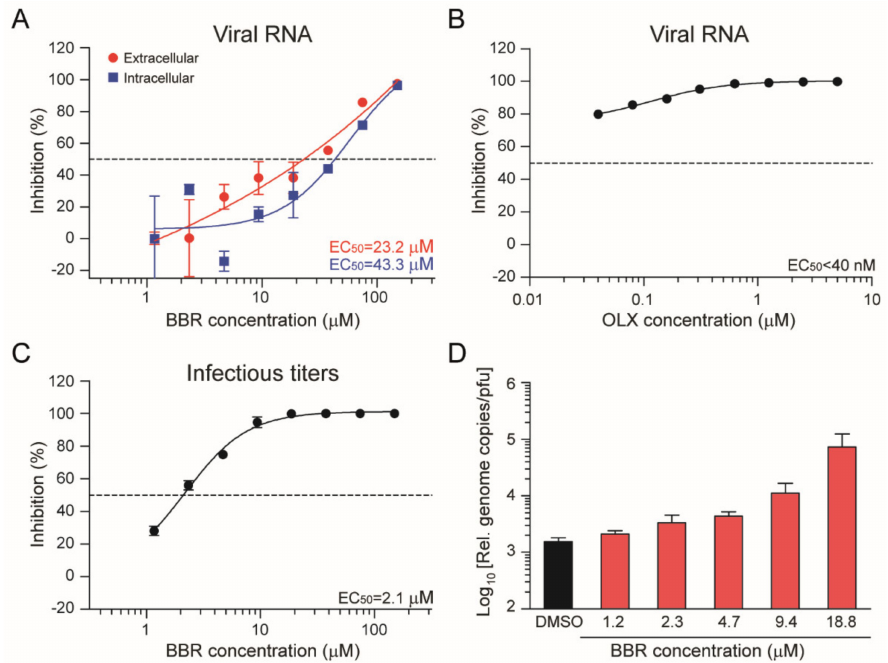
Figure 2. Berberine and obatoclax are effective against SARS-CoV-2 Nijmegen1 isolate. Vero E6 cells were infected with the SARS-CoV-2 Nijmegen1 isolate at an MOI of 0.01 for 24 h in the presence of the indicated concentrations of ( A – C ) berberine (BBR) or ( B ) obatoclax (OLX) in a two-fold dilution series or 0.1% DMSO as a control. ( A , B ) Viral RNA from duplicate cell culture supernatants (red line in panel A) was quantified by qRT-PCR and plotted as percentage inhibition compared to the DMSO control. For BBR-treated cells, both extracellular and Intracellular viral RNA was analyzed (red and blue lines, respectively). Intracellular viral RNA levels were normalized to the human β -actin housekeeping gene. ( C ) Infectious viral titers from duplicate cell culture supernatants were quantified by plaque assay and plotted as percentage inhibition compared to the DMSO control. Error bars indicate SD. Dashed line indicates 50% inhibition. ( D ) The ratio of relative genome copies to infectious viral particles in cell culture supernatants for the indicated, non-toxic BBR concentrations and DMSO